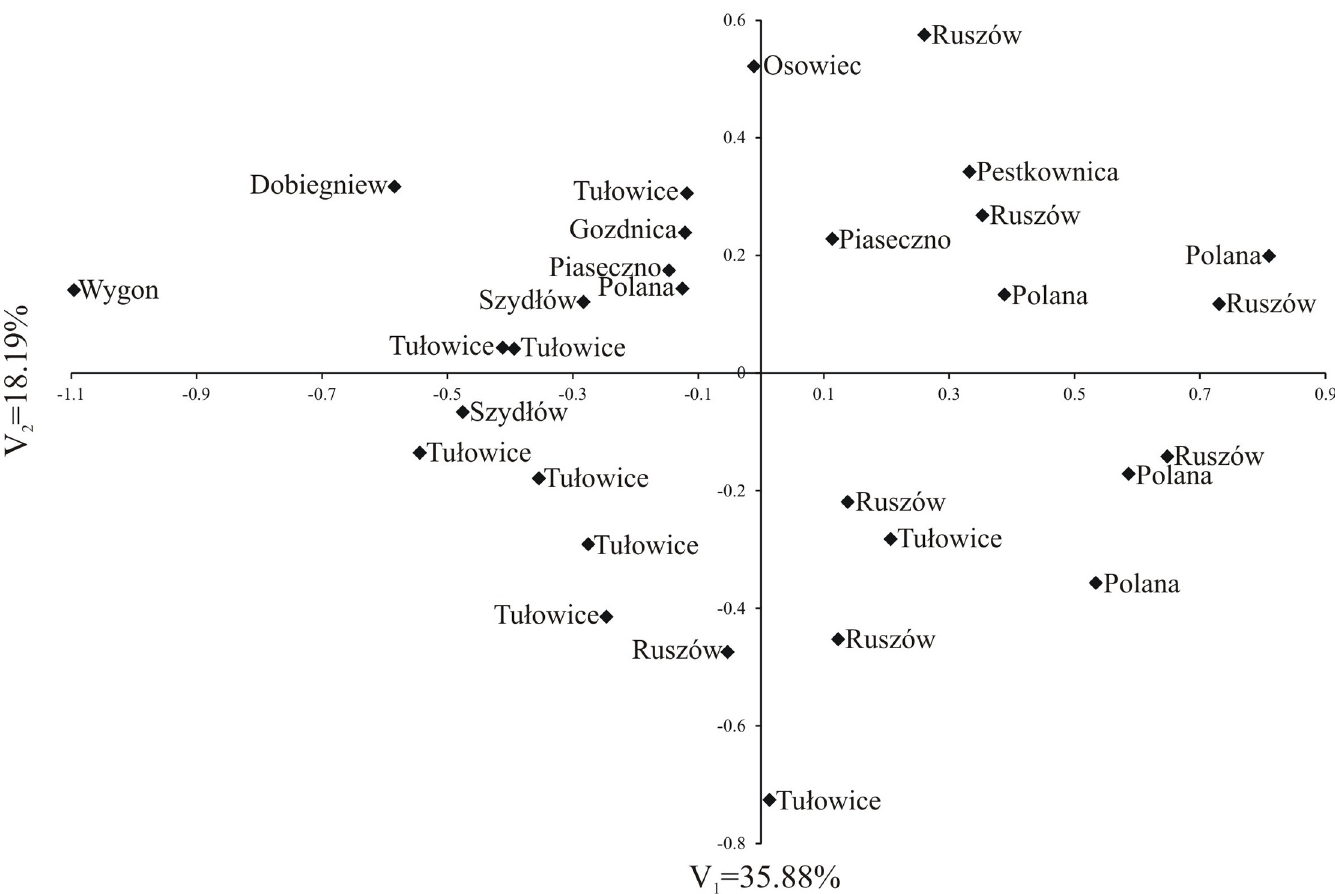
Fig 8. Distribution of 30 S . tomentosa shrubs in space of two first canonical